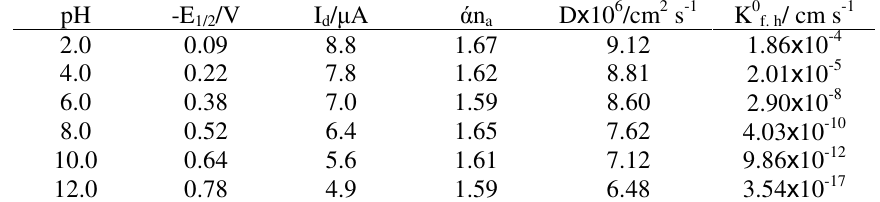
Table 1. Typical D.C. polarographic data of fluchloralin concentration 0.5 mM, Drop time: 3s